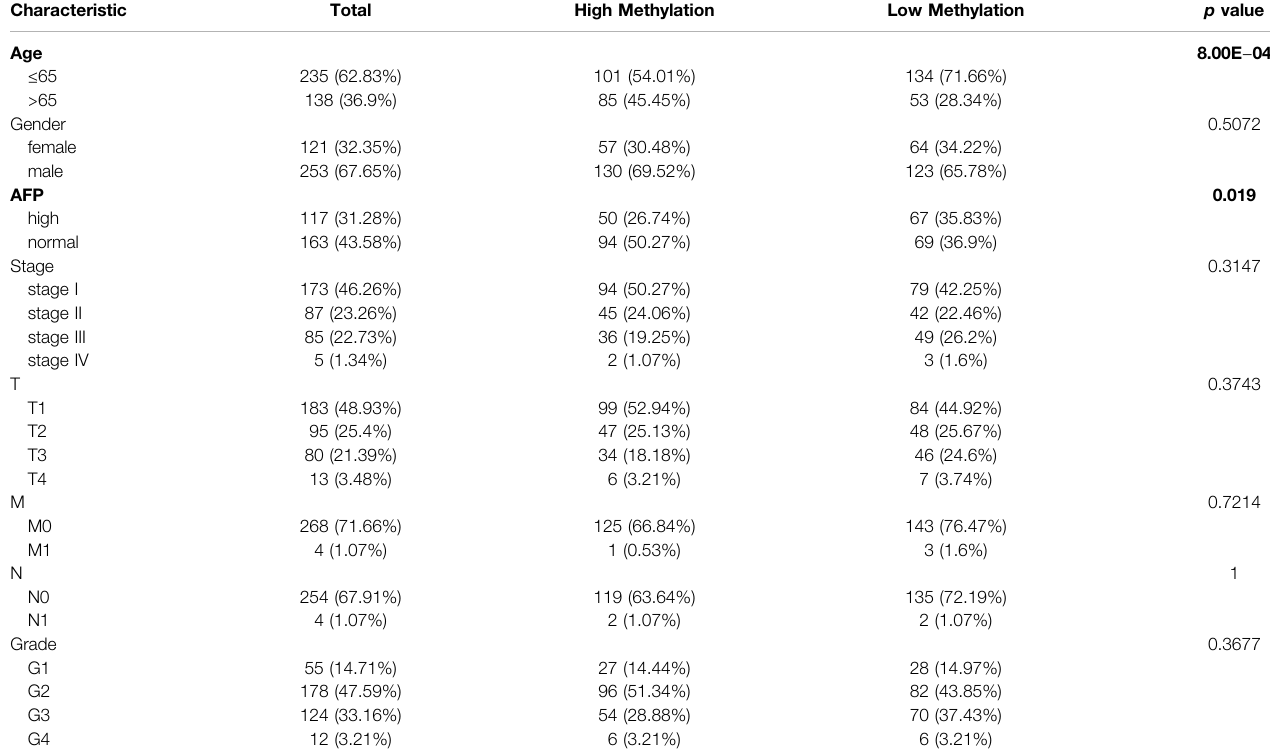
TABLE 2 | The association between RAB42 promoter methylation level and clinical characteristics of patients with HCC from the TCGA. Characteristic